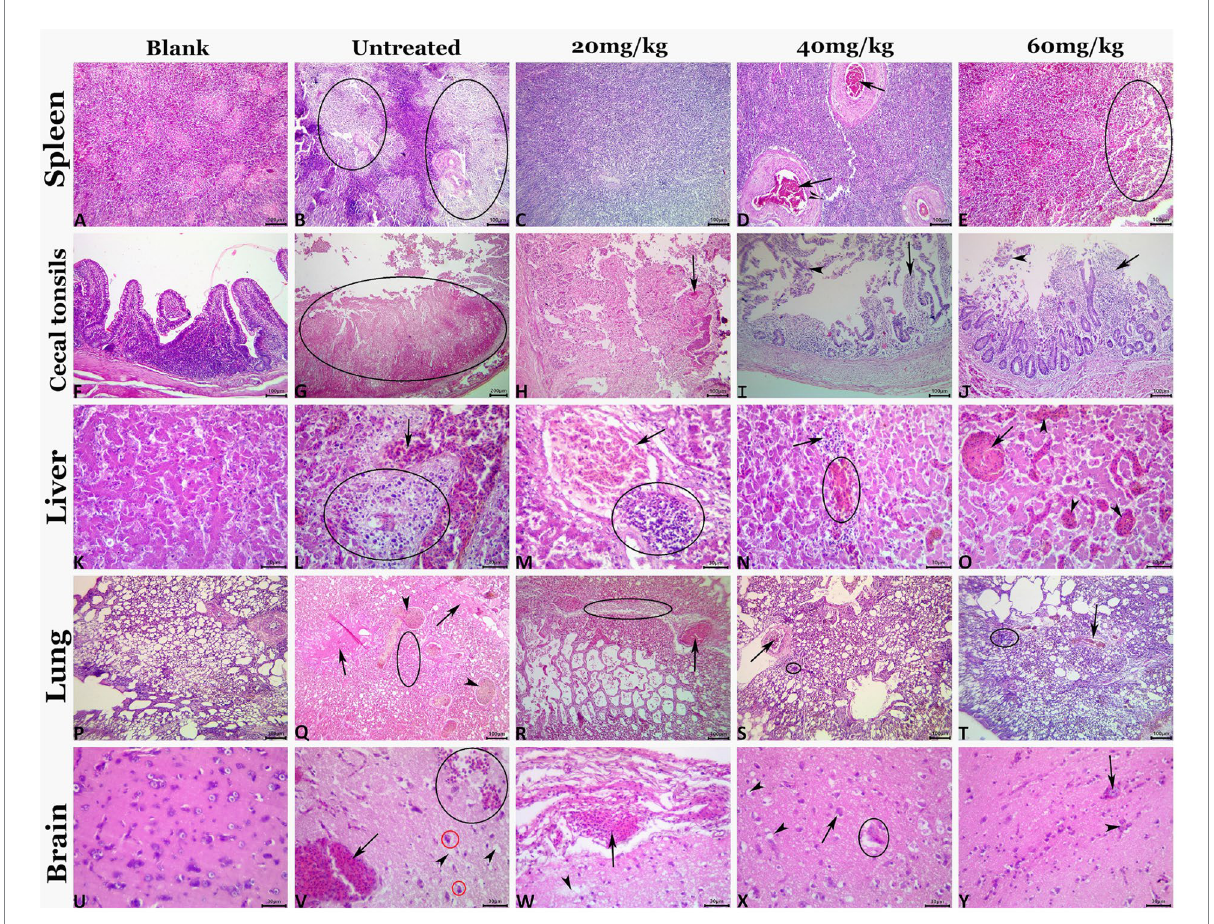
FIGURE 5 Representative photomicrograph of H&E-stained tissue sections demonstrating histopathological alterations in experimentally NDV infected chicken groups treated with 20, 40, and 60 mg/kg n-docosanol. The blank panel shows normal histology for all tissues of the control negative chickens. The NDV-infected untreated panel shows lymphoid depletion (ellipses) in the splenic tissue (B), mucosal coagulative necrosis (ellipse), and luminal hemorrhagic content in cecal tonsils (G), notable vascular congestion (arrow), and focal area of coagulative necrosis infiltrated with inflammatory cell infiltrate (ellipse) in the hepatic tissue (L), prominent vascular congestion (arrowhead), pulmonary edema (arrows) and inflammatory cell infiltrates (ellipse) in the pulmonary tissue (Q), and notable vascular congestion (arrow), neuronal pyknosis with perineural vacuolation (red ellipses), hemorrhage (black ellipse), and neuropil microcavitation (arrowheads) in the brain tissue (V). The 20 mg/kg panel shows diffuse lymphoid depletion in the spleen (C), mucosal coagulative necrosis with hemorrhage (arrow) in cecal tonsils (H), portal congestion (arrow), and focal mononuclear cell infiltrate (ellipse) in hepatic tissue (M), congestion (arrow), and focal mononuclear cell infiltrate (ellipse) in pulmonary tissue (R), meningeal congestion (arrow), and neuropil microcavitation (arrowhead) in the brain (W). The 40 mg/kg panel shows vascular congestion (arrows) in the spleen (D), mucosal mononuclear cell infiltration (arrow) with epithelial desquamation (arrowhead) in cecal tonsils (I), minute hemorrhage (ellipse) and mononuclear cell infiltrations (arrow) in hepatic tissue (N), congestion (arrow), and minute mononuclear cell infiltration (ellipse) in pulmonary tissue (S), and neuronal pyknosis with perineural vacuolation (arrow), neuropil microcavitation (arrowhead), and neuronophagia (ellipse) (X). The 60 mg/kg panel shows focal lymphoid depletion (ellipse) in the spleen (E), mucosal mononuclear cell infiltration (black arrow) with epithelial desquamation (arrowhead) in cecal tonsils (J), almost normal histological picture except for sinusoidal dilatations (arrowheads), and vascular congestion (arrow) in hepatic tissue (O), congestion (arrow), and focal mononuclear cell infiltrate (ellipse) in pulmonary tissue (T), and congestion (arrow), and glial clustering (arrowhead) in the brain